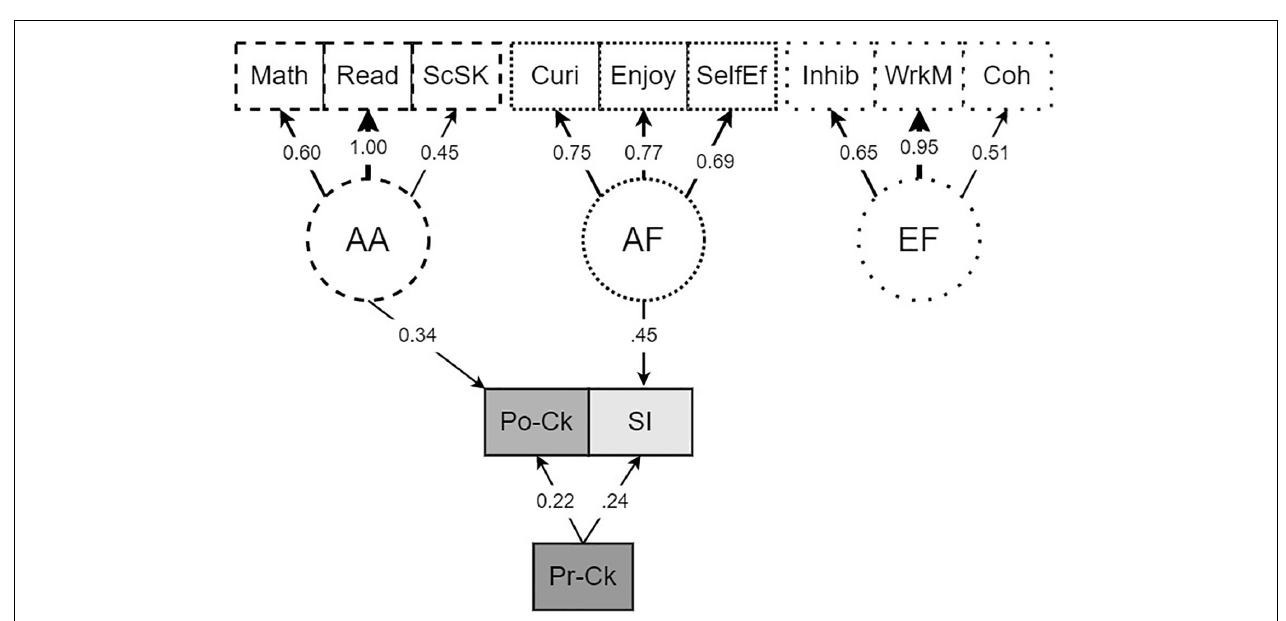
FIGURE 4 | Final factor score regression model. The final model was specified with direct paths on the outcome variables post content knowledge (Po-Ck) and situational interest (SI). Predictors are pre content knowledge (Pr-Ck) and latent variables (circles): academic abilities (AA), indicated by science skills (ScSk), reading (Read), and math; affective (AF), indicated by self-efficacy (SelfEf), enjoyment (Enjy), and curiosity (Curi); executive functioning (EF), indicated by coherence of speech (Coh), working memory (WrkM), and inhibition (Inhib). Arrows that are missing between latent and outcome variables indicate non-significant paths.